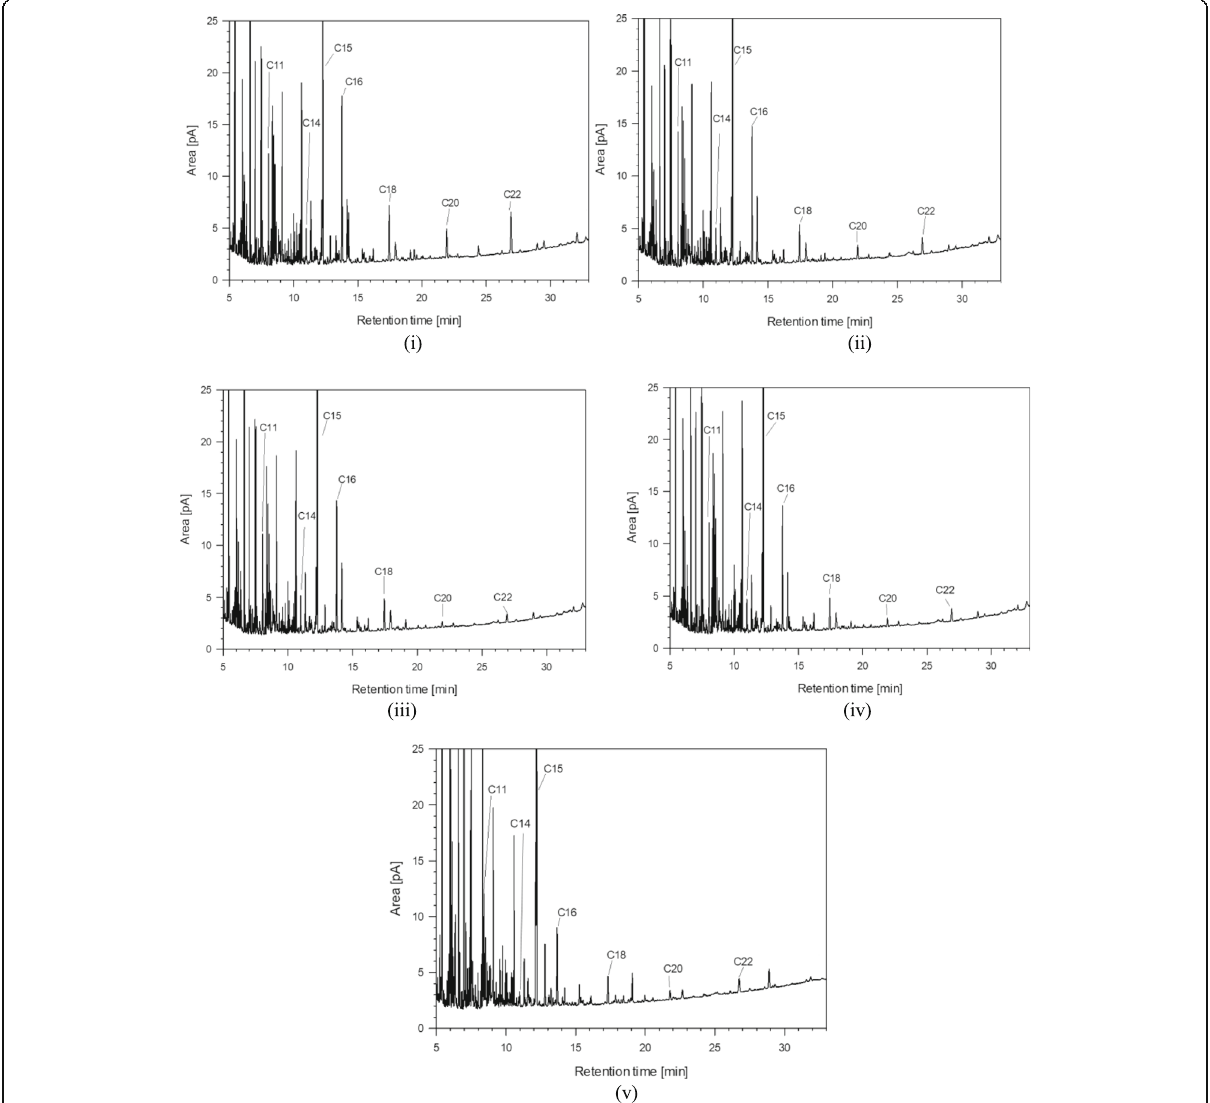
Fig. 8 Representative GC-FID chromatograms of fingerprint residue from donor E, i chloroform:ethanol (1:1), ii acetone:chloroform:hexane (1:1:1), iii hexane:isopropanol (3:2), iv chloroform:methanol (3:1), and v